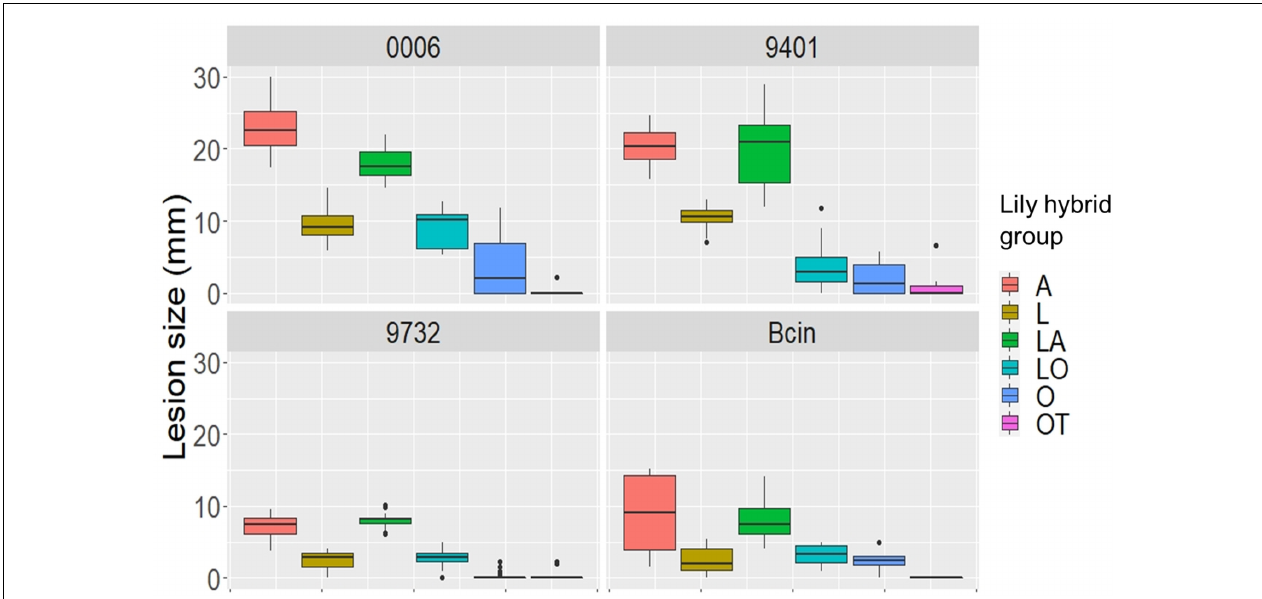
FIGURE 7 | Lesion diameters at 3 dpi upon inoculation of B. elliptica isolates Be9401, Be9732, and Be0006 and one B. cinerea isolate on flowers of 12 lily genotypes. Lesion diameters measured in mm of each single fungus are plotted separately in the four panels. Each of the colored boxes represents all lesion diameters measured for a given lily hybrid